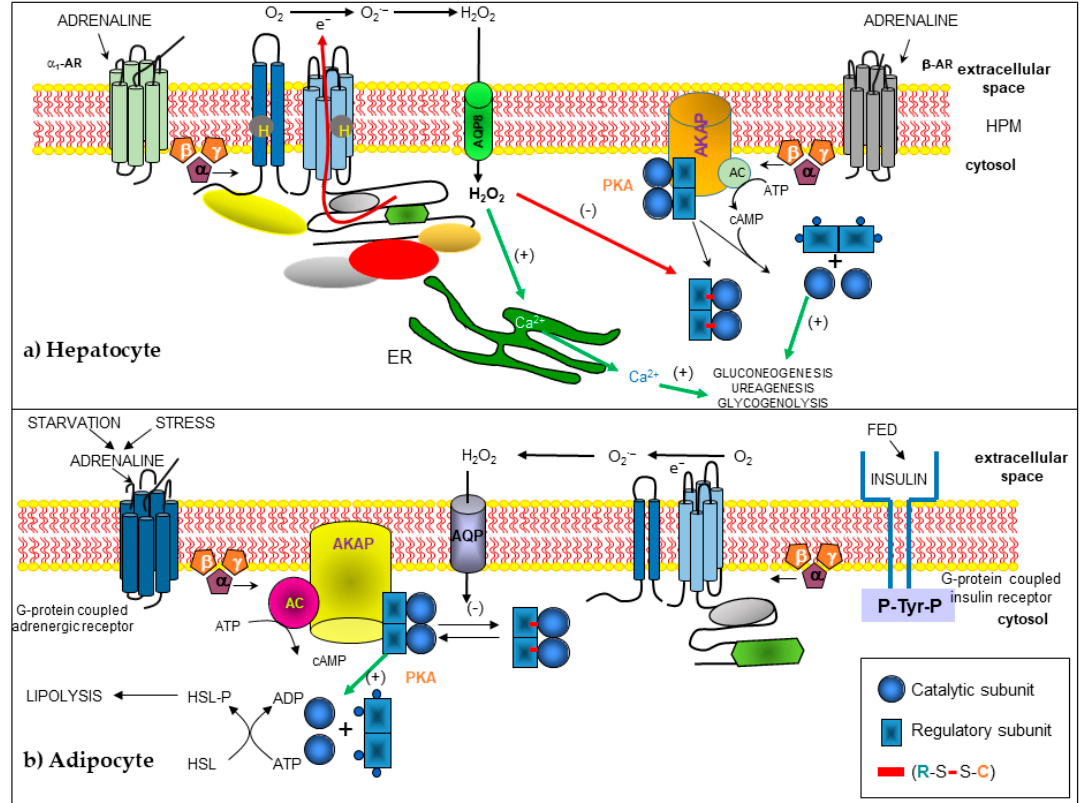
Figure 2. Modified schemes from [85] and [89], in which the signaling and cross-linking pathways are presented and where H 2 O 2 participates as a second messenger, generated by the activation of an NOX. H 2 O 2 enters the cell through an aquaporin that modifies the redox state of protein kinase A (PKA), producing a disulfide (-) bond between the regulatory and catalytic subunits that alters the activation and function of the holoenzyme PKA by cAMP. ( a ) In the hepatocyte, the activation of α 1 adrenergic receptors ( α 1-AR) inhibits the activation of PKA. Reproduced with permission from Magdalena Vilchis-Landeros, Raquel Guinzberg, H é ctor Riveros-Rosas et al., and FEBS Letters, and published by John Wiley and Sons, 2020. ( b ) In the adipocyte, the lipolysis pathway is inhibited by the oxidation of PKA, due to the generation of H 2 O 2 , stimulated by insulin.